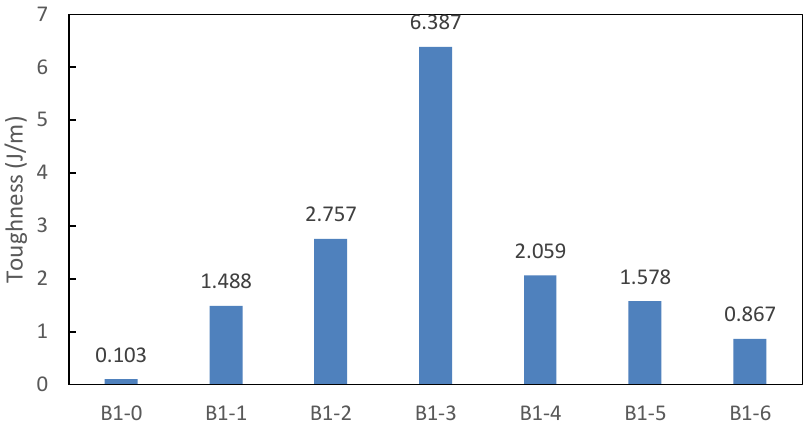
Fig. 11. Impact toughness for (B1-0, B1-1, B1-2, B1-3, B1-4, B1-5, and B1-6).